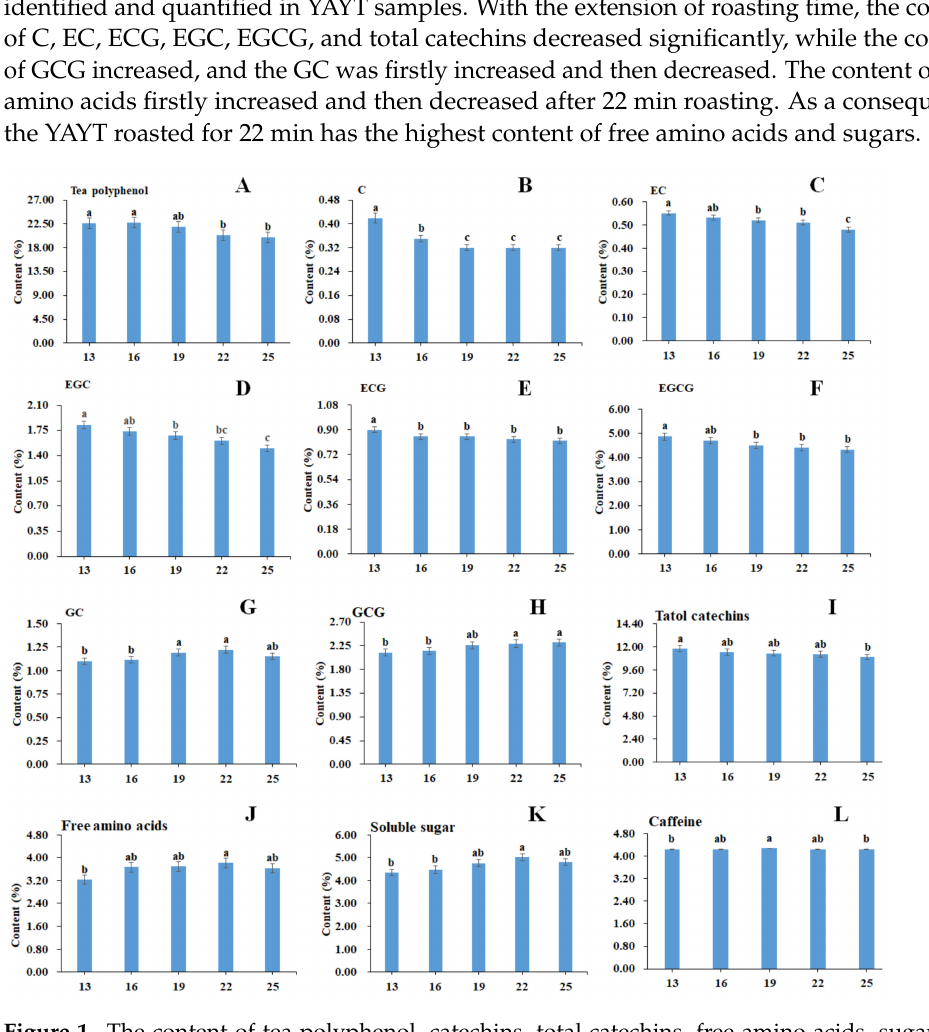
Figure 1. The content of tea polyphenol, catechins, total catechins, free amino acids, sugar, and caffeine in YAYT with different roasting times. ( A ) Tea polyphenol; ( B ) C; ( C ) EC; ( D ) EGC; ( E ) ECG; ( F ) EGCG; ( G ) GC; ( H ) GCG; ( I ) Total catechins; ( J ) Free amino acids; ( K ) Solutable sugar; ( L ) Caffeine. Columns labeled with ‘a’, ‘b’, and ‘c’ had significant differences ( p < 0.05) from each